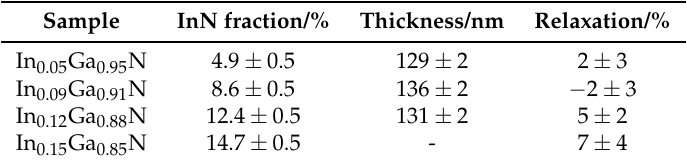
Table 1. List of InGaN sample properties, gained from XRD analysis of the symmetric 0002 reflection.